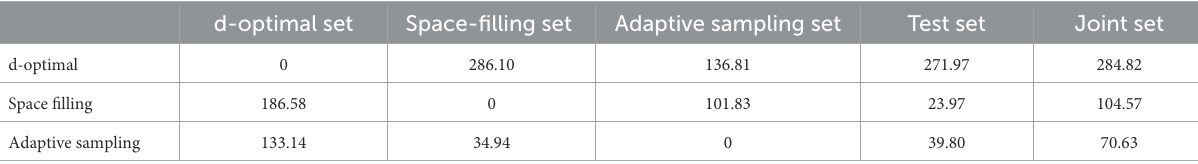
TABLE 3 HIC 36 mae of the trained models on the available datasets.